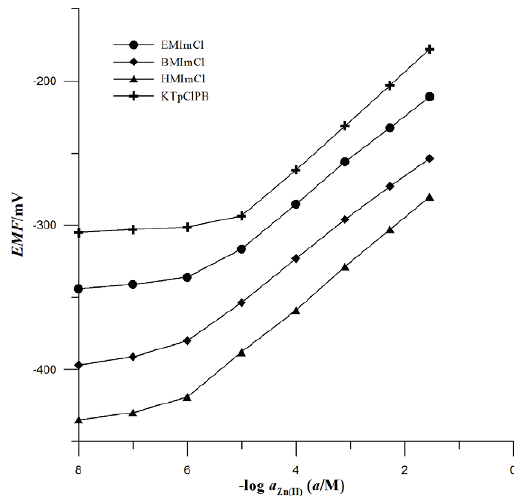
Figure 3. Effect of ionic additive on zinc electrode response. Figure 4. Effect of plasticizer on zinc electrode